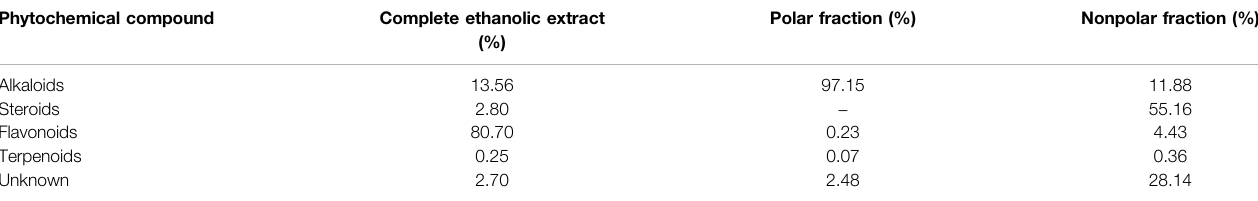
TABLE 3 | Phytochemical compounds present in the ethanolic extract and polar and nonpolar fractions of Lophocereus schottii . The percentages were obtained by summation of those obtained for each extract or fraction. Phytochemical compound